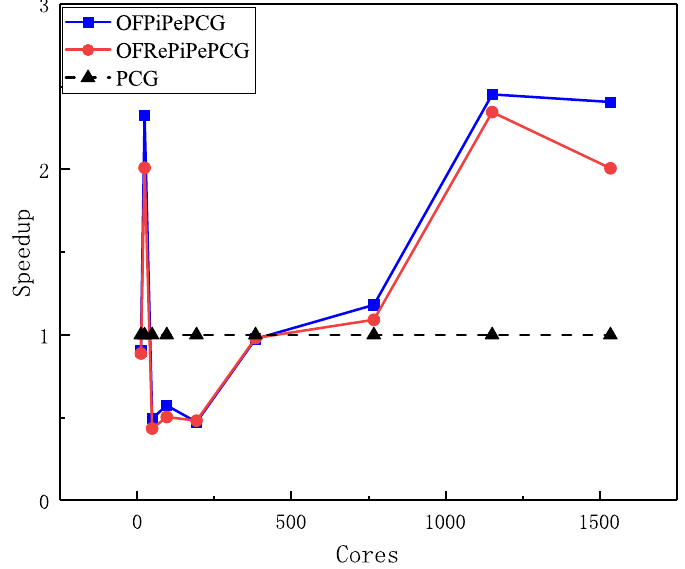
Figure 11. Strong scaling speedups relative to PCG (cavity).